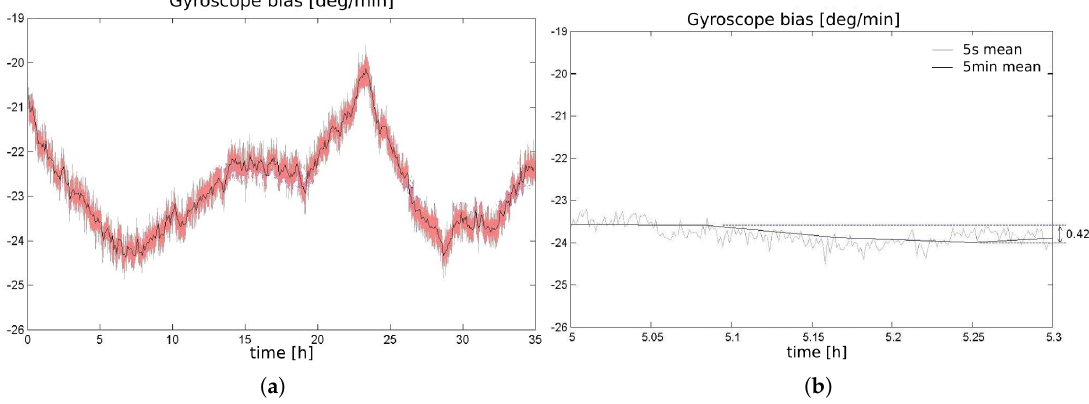
Figure 20. Brown noise characteristic of the gyroscope bias (T = 38 ◦ C): ( a ) long time observation; ( b ) 18 min observation from hour 5 to hour